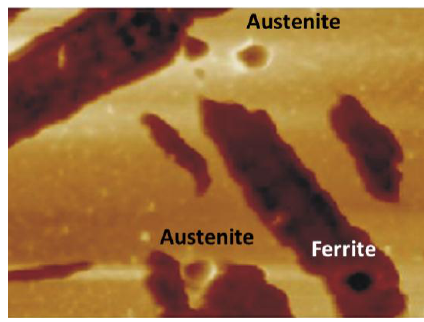
Figure 15. Atomic force microscopy (AFM) image showing previously performed indentations in either bainitic ferrite or austenite, in a nanobainitic structure treated at 300 °C, described in reference [15].